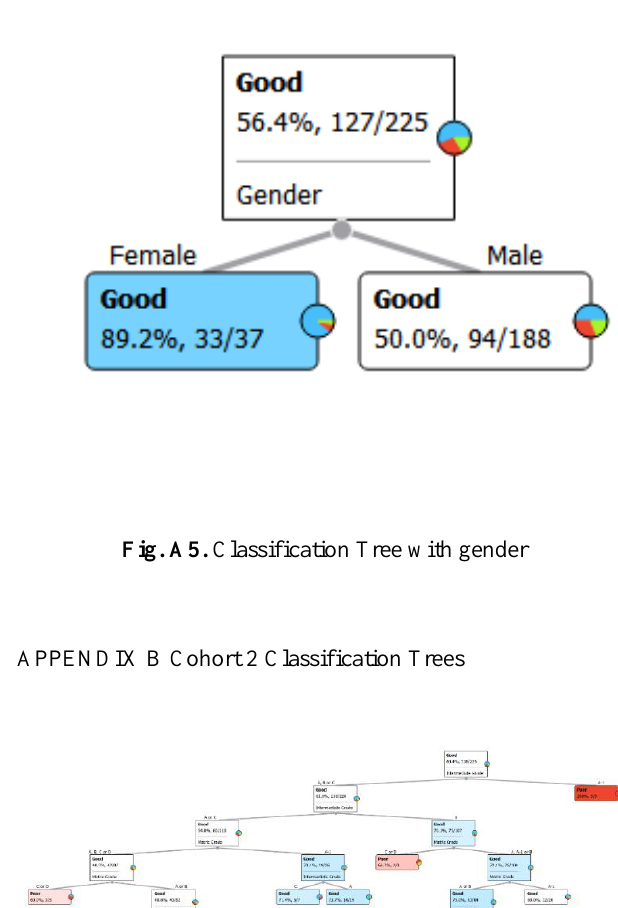
Fig. A2. Classification Tree with programming courses and CGPA